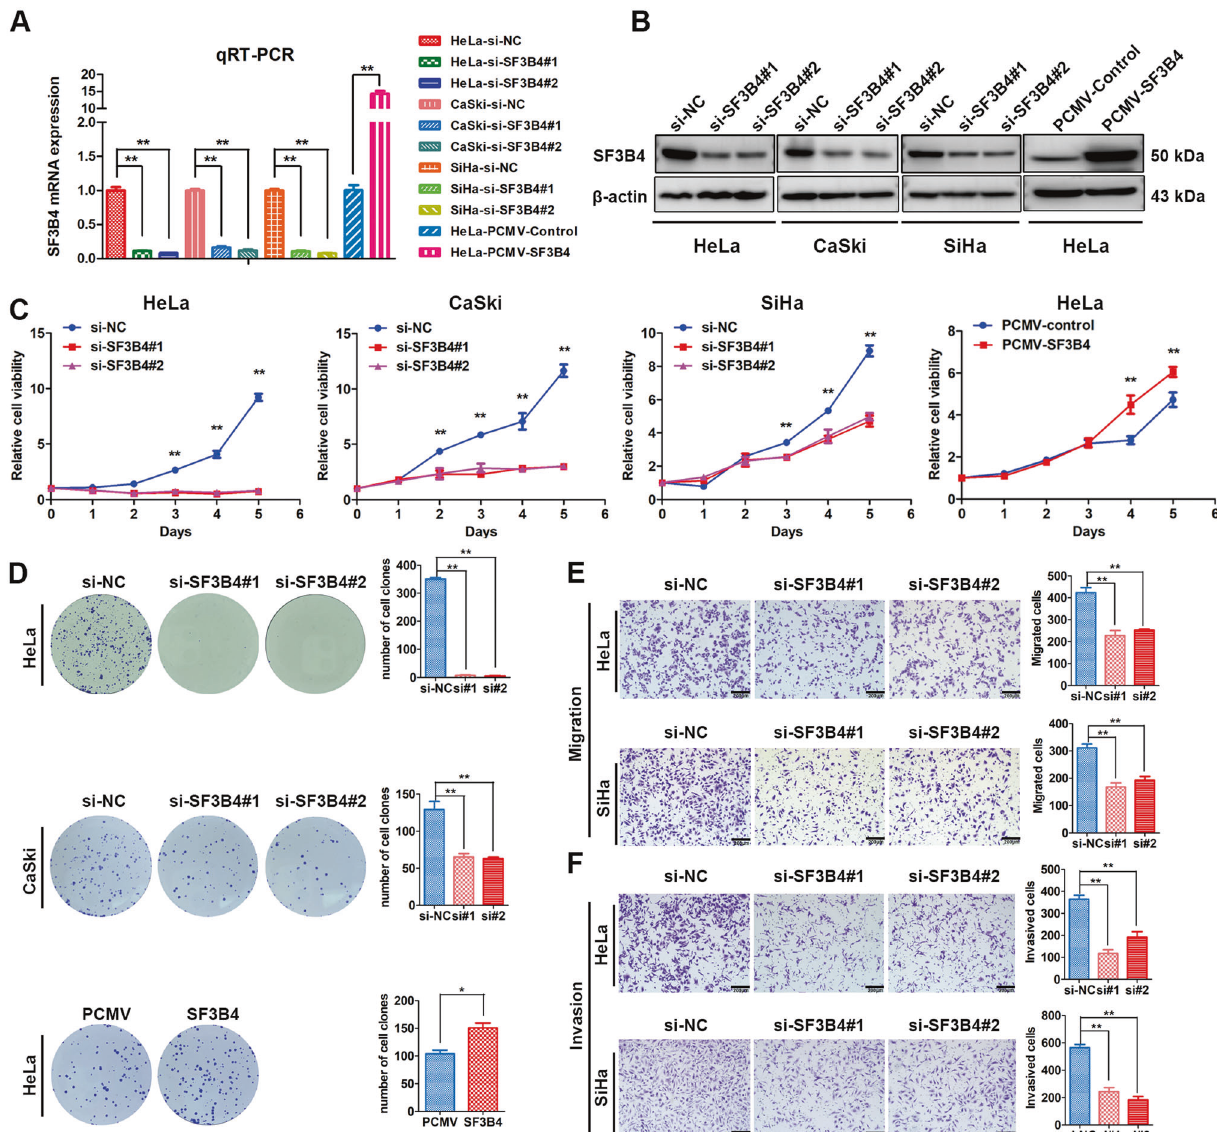
Fig. 2 SF3B4 promotes the proliferation and motility of cervical cancer cells. A , B qRT-PCR and western blot analysis of SF3B4 mRNA and protein expression after transfection with SF3B4-siRNA and PCMV-SF3B4 vector in cervical cancer cells ( n = 3 biologically independent samples). C Proliferation curve showing the impact of SF3B4 knockdown or overexpression on the growth ability of cervical cancer cells ( n = 5 biologically independent samples). D The effect of SF3B4 knockdown or overexpression on the colony formation capacity of cervical cancer cells ( n = 4 biologically independent samples). E , F Changes in migration and invasion abilities after SF3B4 downregulation in HeLa and SiHa cells ( n = 3 biologically independent samples). P value was obtained by Unpaired t-test. * P < 0.05, ** P <